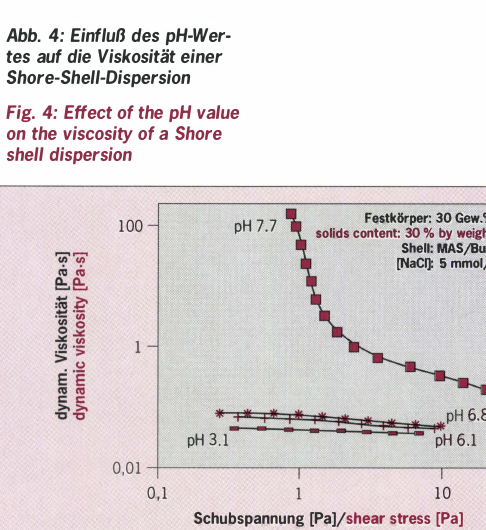
Abb. 3: Viskositiit als Funkti­ on des Festkiirpergehaltes (80% neutralisiert} Fig. 3: Viscosity as function of the solids content (80% neutralised}